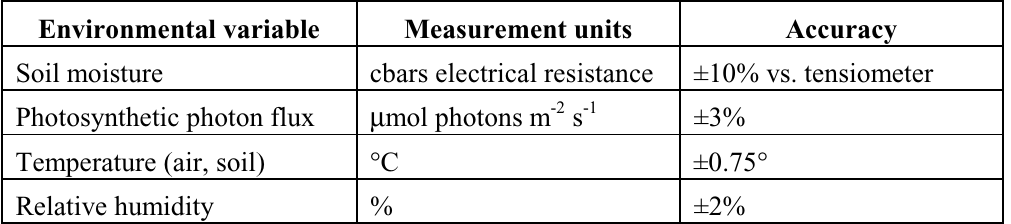
Table 1. Pod Sensors for Sensor Webs 2 and